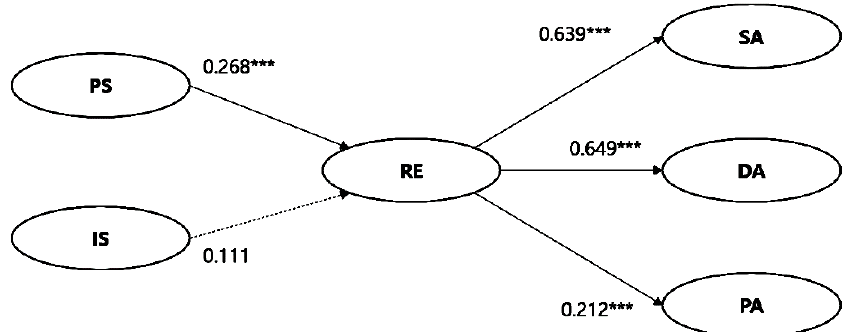
Figure 2. Structural model with standardized path coefficients. Note: *** p < 0.001. DA, distancing activity; IS, individual support; PA, purchasing activity; PS, public support; RE, response efficacy;